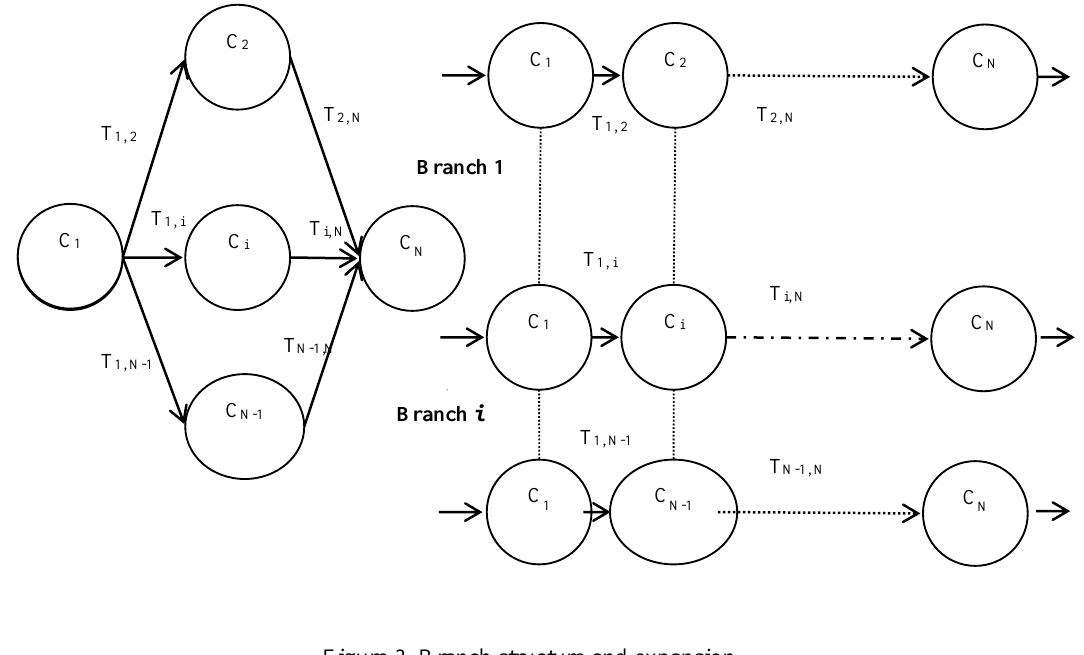
Figure 3. Branch structure and